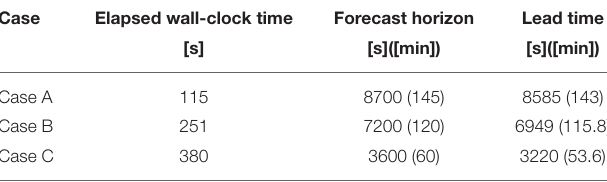
TABLE 4 | Running times and lead times for all